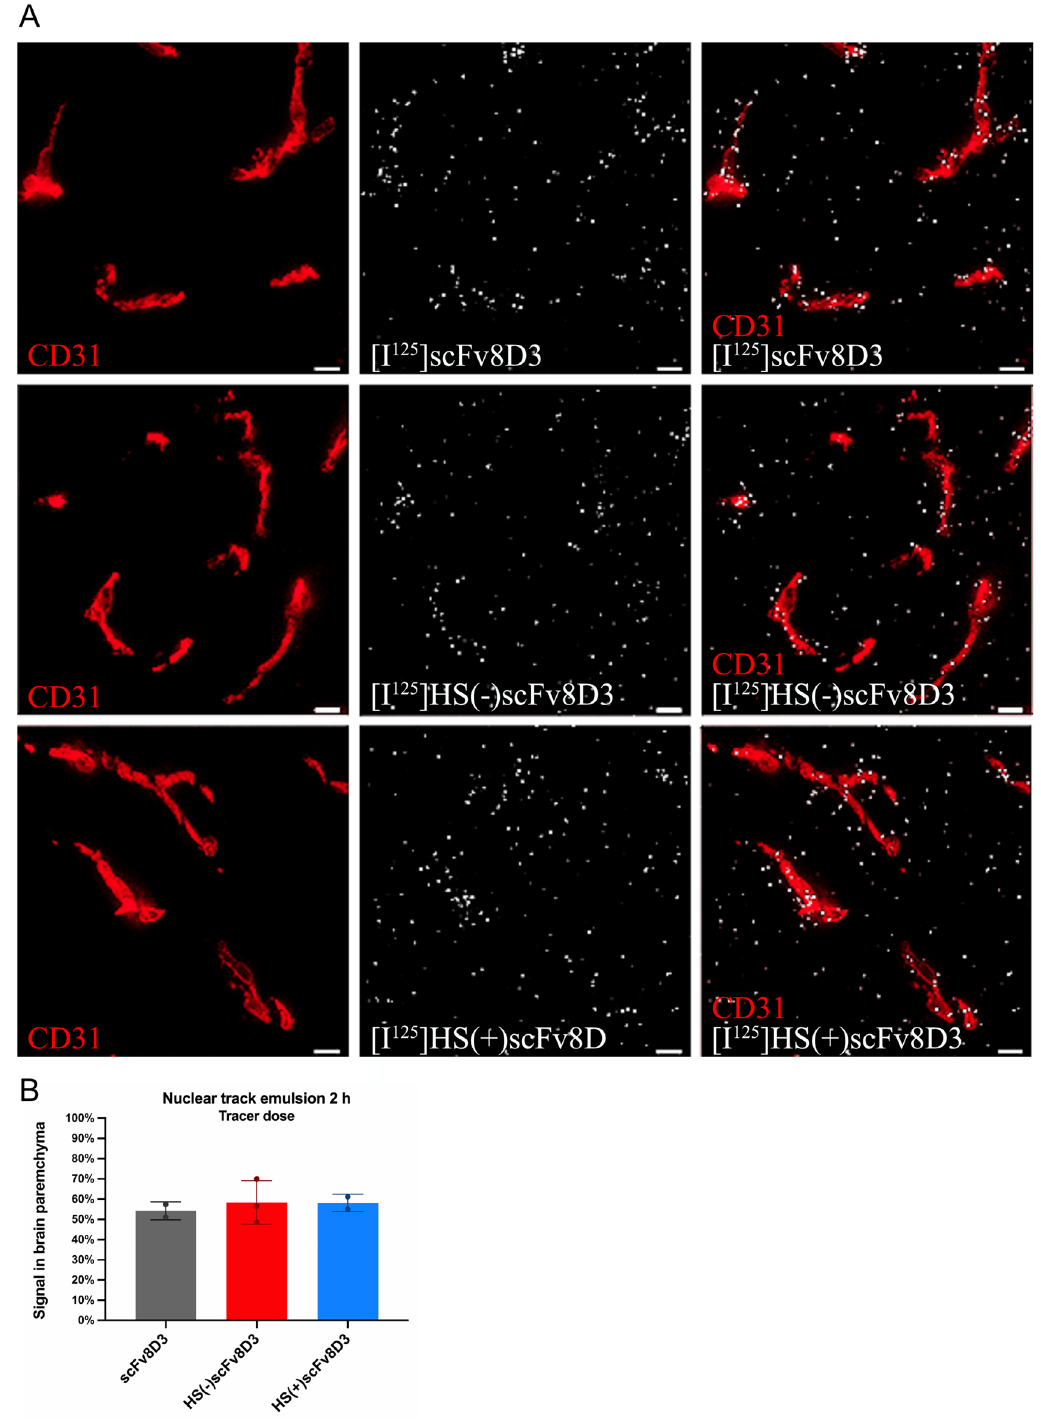
Figure 9. Ex-vivo brain nuclear track emulsion (NTE) shows the three [ 125 I]scFv constructs similarly distributed in the brain parenchyma. The NTE results were attained from ex-vivo 2 h post injection studies of animals injected with tracer dose (0.3 nmol/kg) of [ 125 I]scFv8D3 (n = 2), the [ 125 I]HS(−)scFv8D3 mutant (n = 3) or [ 125 I]HS(+)scFv8D3 mutant (n = 2). ( A ) Representative images of NTE (white puncta) detecting [ 125 I]scFv8D3, [ 125 I]HS(−)scFv8D3 mutant or [ 125 I]HS(+)scFv8D3 mutant, and CD31 brain capillary staining (red) in mouse brains. White scale bar = 10 μm. ( B ) Semi-quantification of NTE images was performed for the association of white puncta (antibody-derived signal) within the brain parenchyma or colocalized with the CD31-fluorescently stained brain capillaries. Results are presented as mean ±